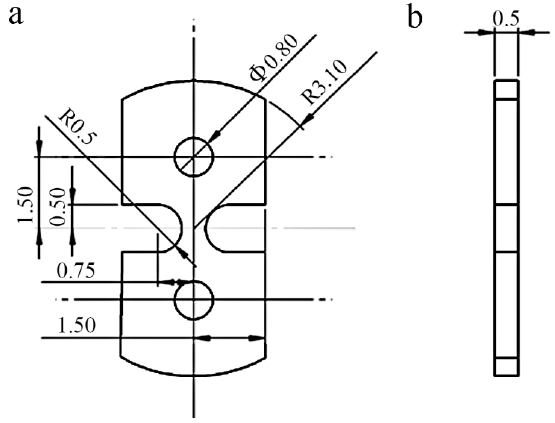
Figure 1. Dimensions of the specimen: ( a ) front view; and ( b ) side view (units are in mm). Table 1. Neck elongation and initial crystal orientation of each specimen.